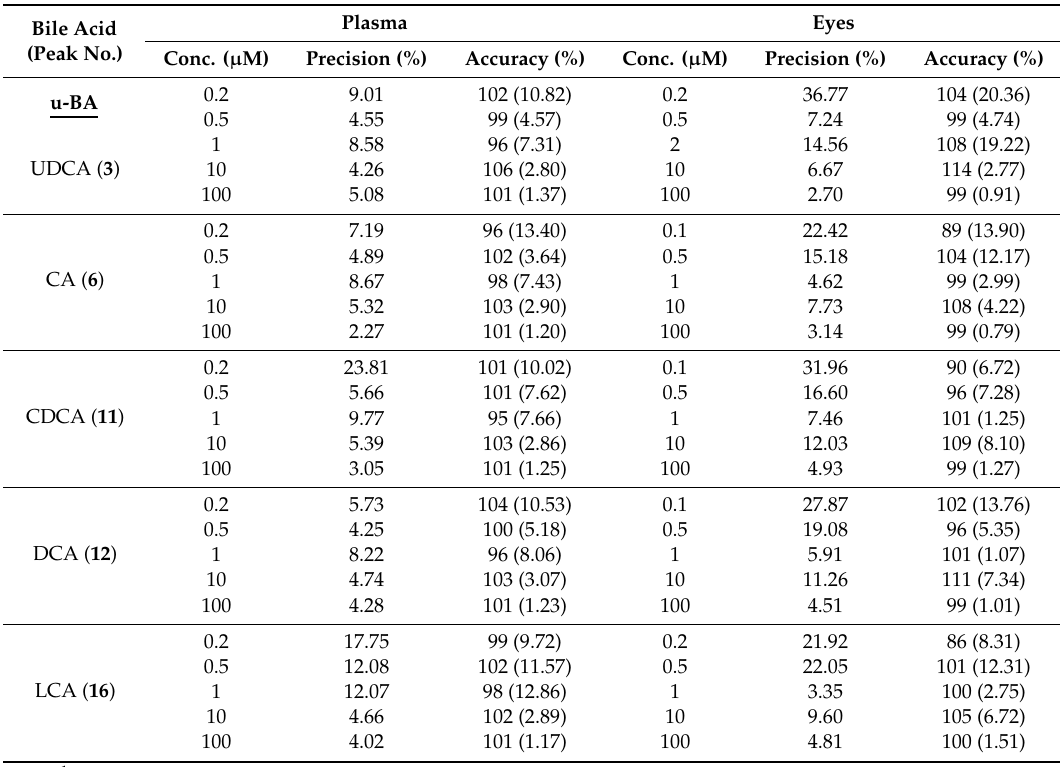
Table 3. HPLC method validation results of unconjugated bile acids (u-BA) in mice plasma and eyes ( n = 3) 1